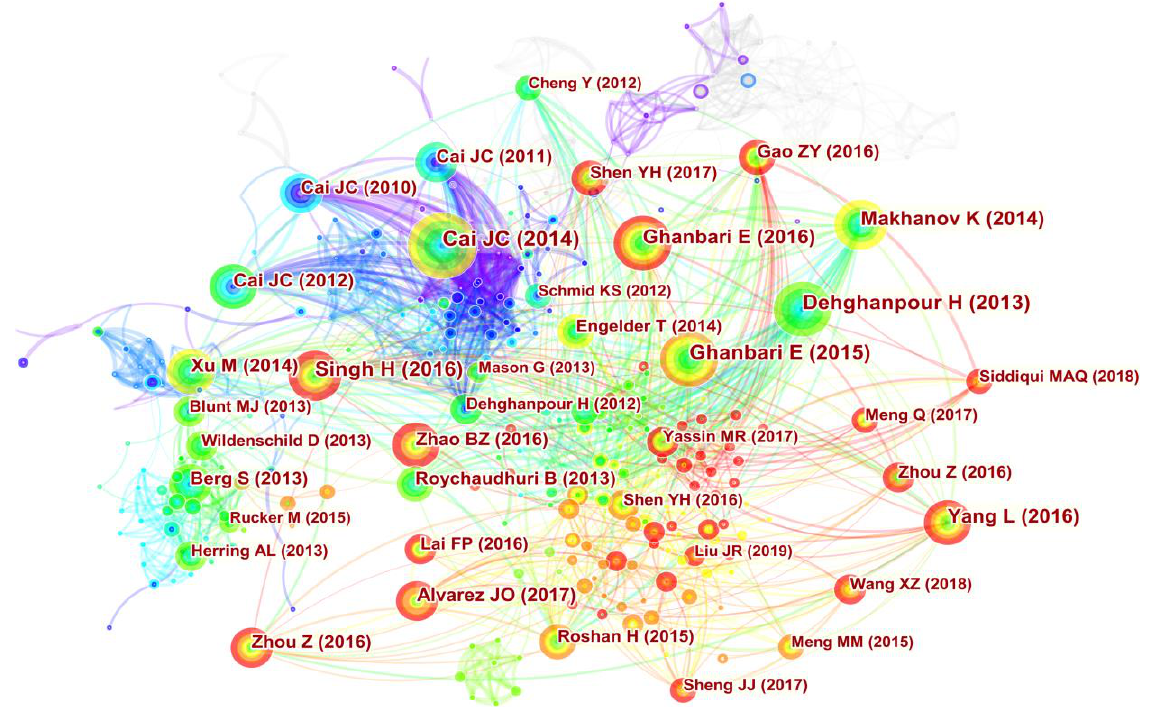
Figure 10. Reference co-citation network.